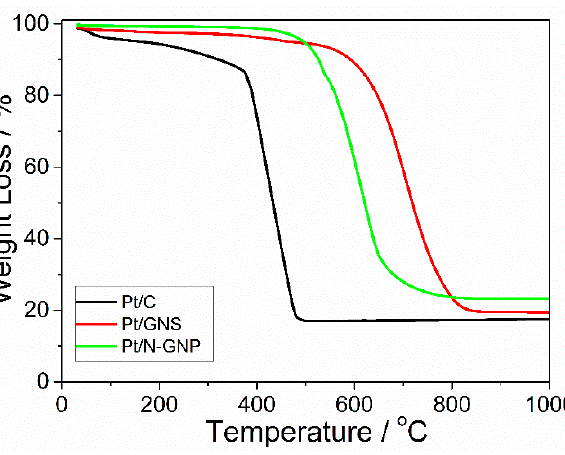
Figure 1. Thermogravimetric analyses of Pt/C, Pt/GNS and Pt/N-GNP catalysts. The measurements were performed in air atmosphere up to 1000 °C with a heating ramp of 10 °C min − 1 . Abbreviations: GNS, graphene nanosheets; GNP, graphene nanoplatelets.